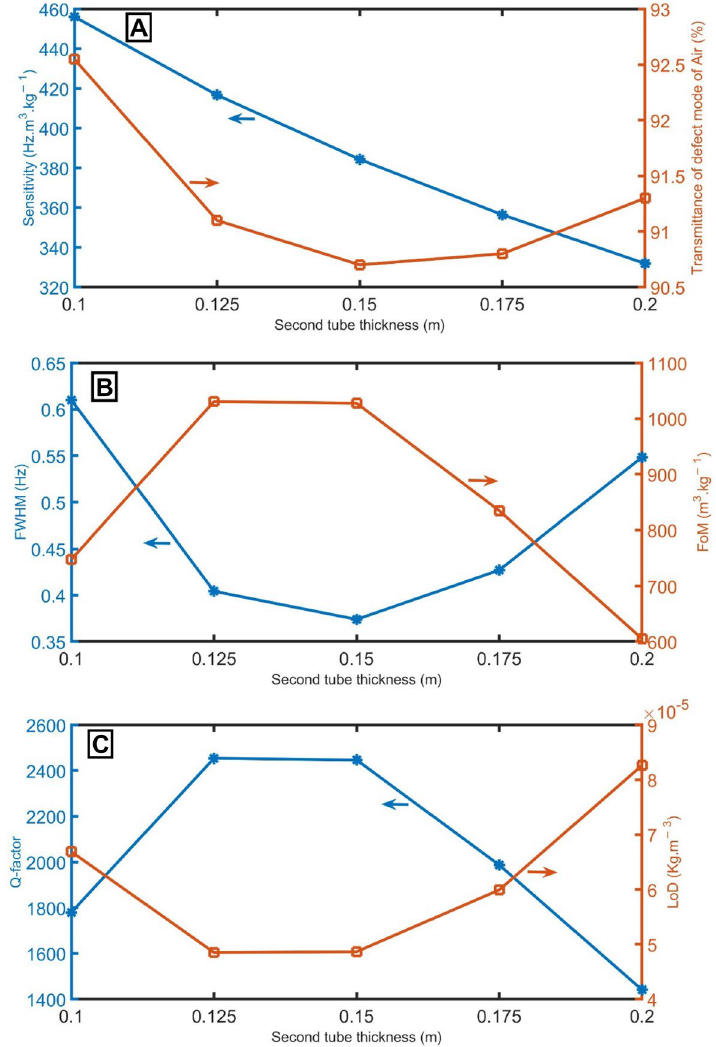
Figure 5. ( A ) sensitivity between air and pure CH 4 samples and transmittance of the resonant mode of air samples, ( B ) FWHM of the resonant mode of air samples and FoM , and ( C ) Q-factor and LoD of the proposed gas sensor at different values of second tube thickness of the unit